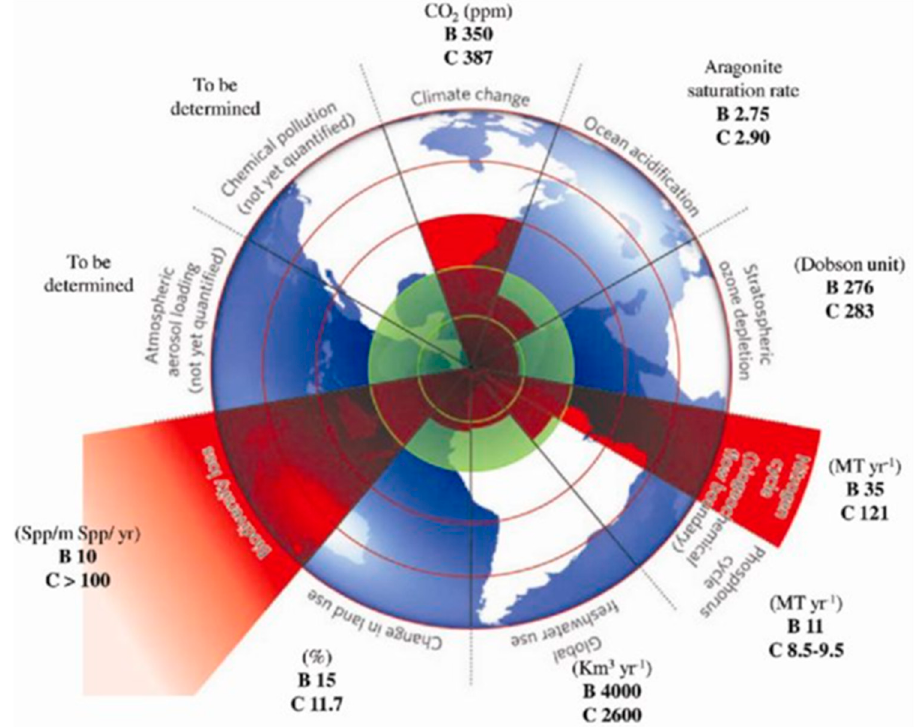
Figure 1. Researcher [16] impression of Rockstrom et al. [15]: “The nine planetary boundaries as safe operating space for humanity B, Proposed boundary; C, Current status”.